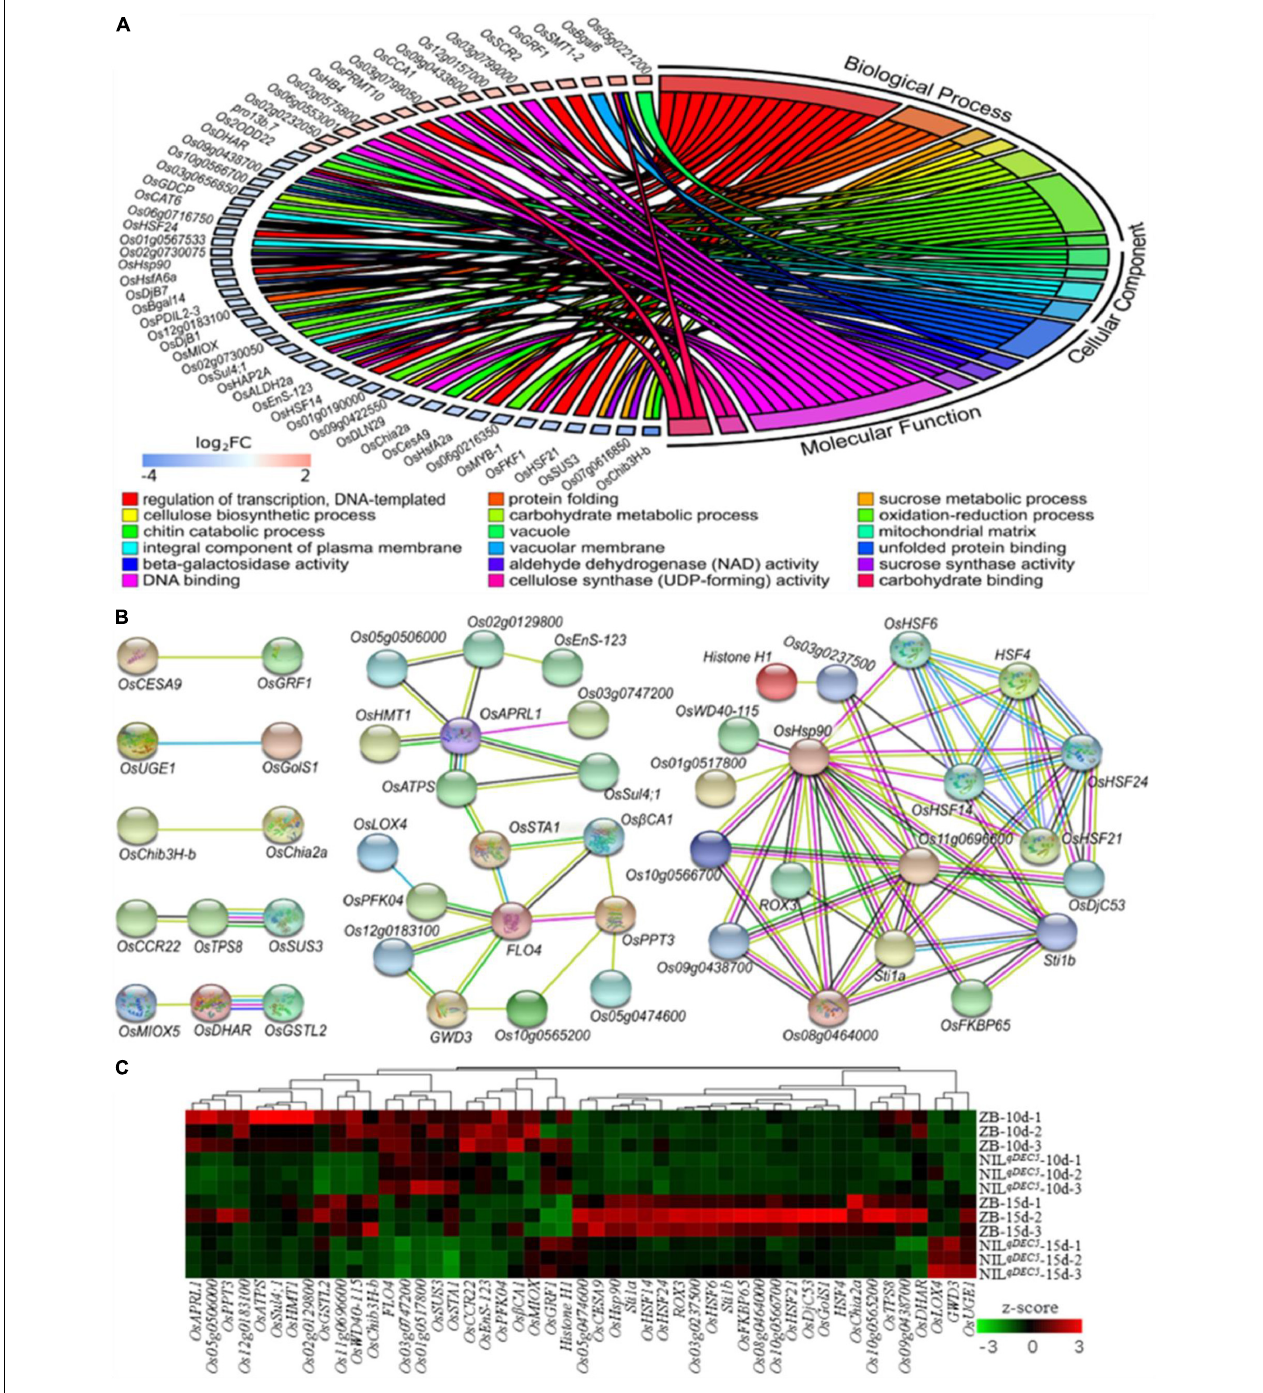
FIGURE 7 | DEGs from the transcriptomic analysis. (A) GO enrichment results of DEGs. (B) The interaction network of DEGs. DeepSkyBlue1 line, from curated databases; DeepPink3 line, experimentally determined; Green line, gene neighborhood; Blue line, gene co-occurrence; OliveDrab3 line, text mining; black line, co-expression; MediumSlateBlue line, protein homology. (C) Hierarchical clustering analysis heat map of the average relative expression levels.